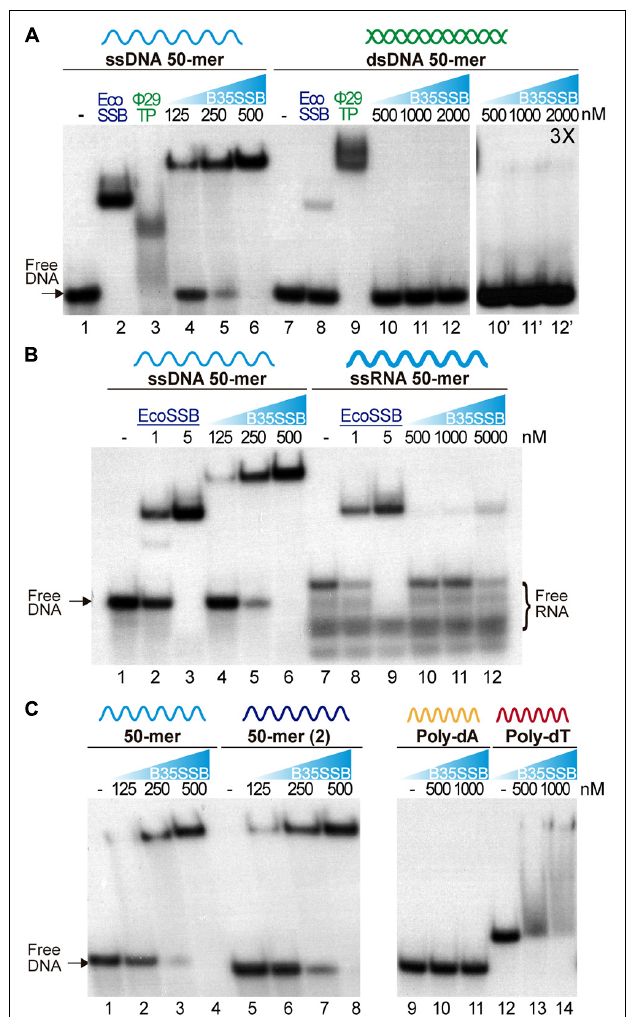
FIGURE 1 | Nucleic acid binding capacity of B35SSB. DNA binding capacity of B35SSB is analyzed by comparison of mobility shift of diverse substrates, ssDNA vs. dsDNA (A) , ssDNA vs. ssRNA (B) or different sequence contexts in ssDNA (C) . EMSA were performed in presence of the indicated amounts of B35SSB and 2 nM of radiolabeled ssDNA, dsDNA, or RNA as indicated. Negative controls, without protein, were loaded in the lanes indicated by a dash. Where indicated, 1 µ M EcoSSB and 20 nM (cid:56) 29 terminal protein ( (cid:56) 29TP) were used as